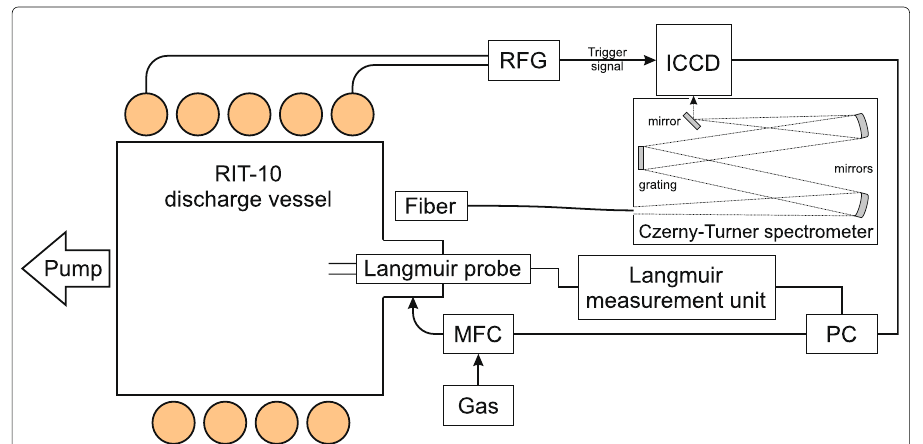
Fig. 3 Experimental setup for simultaneous optical emission spectroscopy and the Langmuir double probe